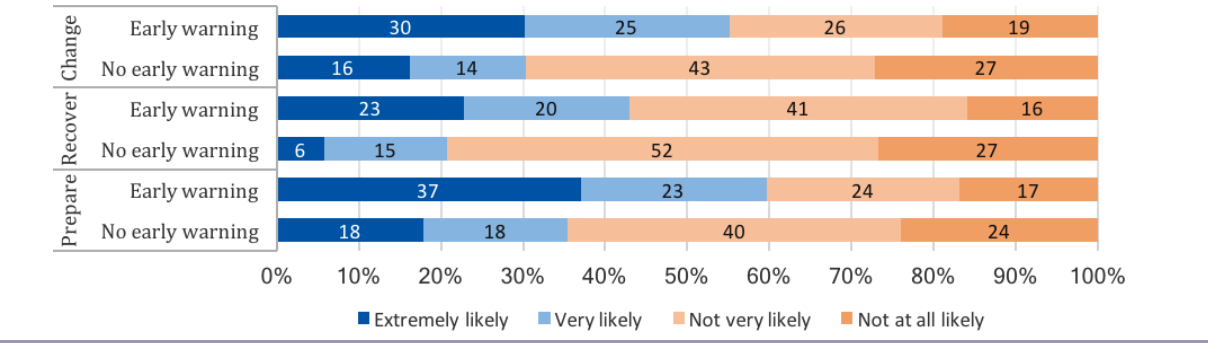
Fig. 3 . Relationships between early warning and resilience-related